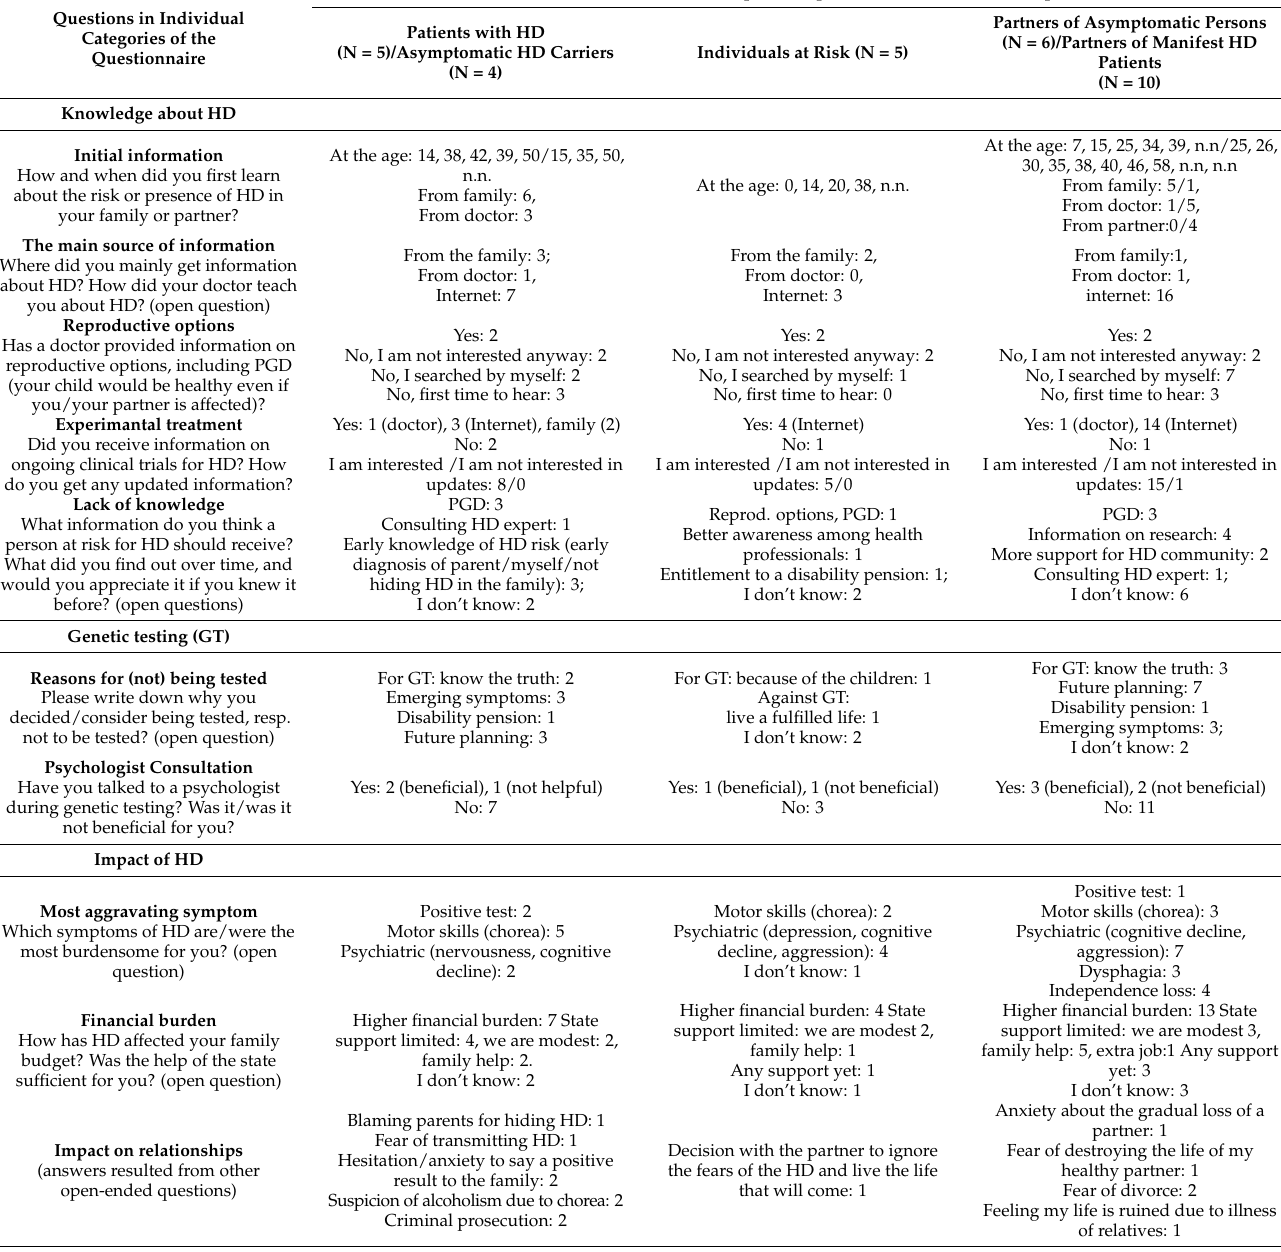
Table 2. Questions and answers of the respondents on the questionnaire administered via the Slovak HD association to patients, persons at risk, their relatives and partners, including their experiences and suggestions for improving the situation for the HD community in SR. The questions have been administered as multiple-choice or as open questions. The table shows an overview and a summary of the available answers. Abbreviations: GT—Genetic Testing; HD—Huntington Disease; N- number of participants; n.n. not known. PGD—Preimplantation genetic diagnosis; SSE—social services establishment; SR—Slovak